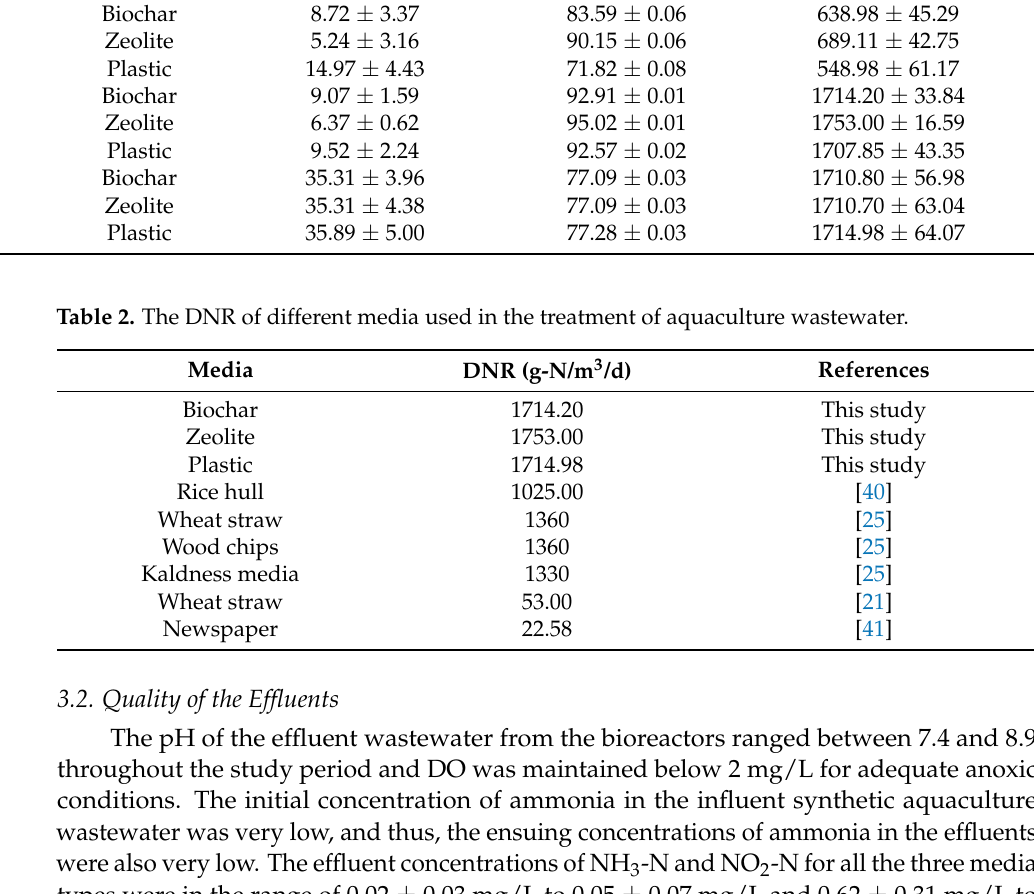
Table 1. Denitrification performance summary of the bioreactors under pseudo-steady-state conditions. Influent NO 3 -N Concentration (mg/L)